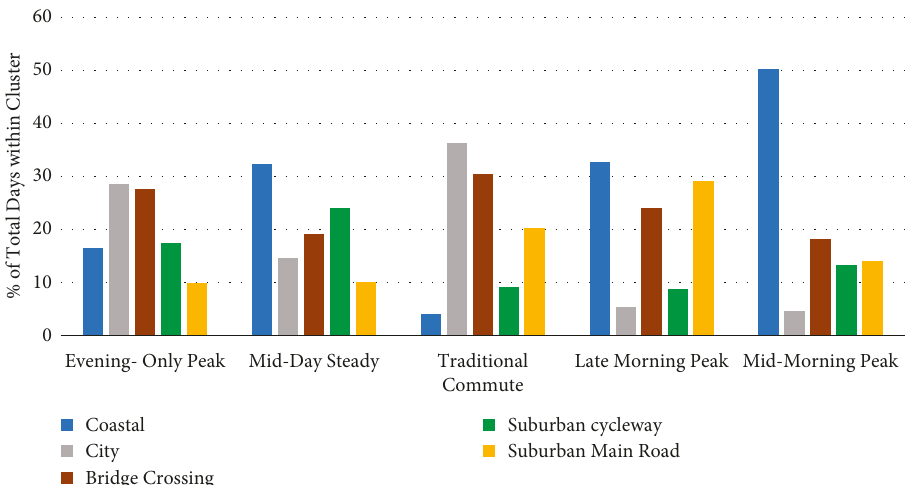
Figure 8: Cluster composition by counter